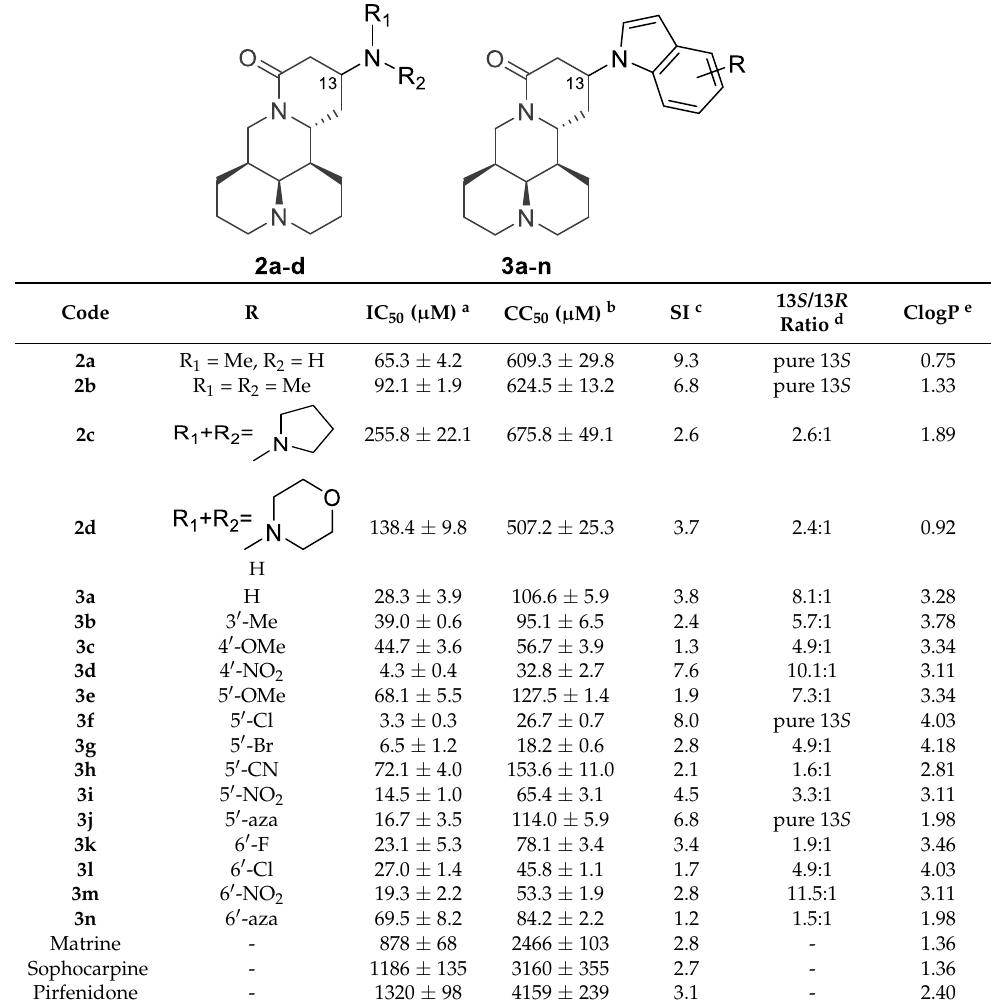
Table 1. Anti-fibrotic activity, cytotoxicity, and selectivity index of matrine derivatives.